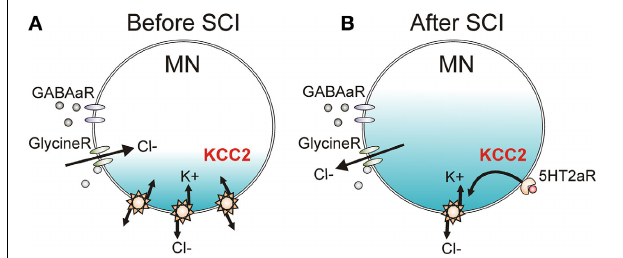
FIGURE 10 | KCC2 cotransporter and chloride equilibrium before and after SCI. (A) A potassium chloride cotransporter (KCC2) removes chloride (Cl − ) from the motoneuron (MN) in exchange for potassium (K + ) to maintain Cl − equilibrium potential below resting membrane potential, allowing Cl − influx and MN hyperpolarization during activation of GABA and Glycine receptors (R). (B) Downregulation of KCC2 expression in motoneurons after SCI increases intracellular Cl − concentration, depolarizing Cl − equilibrium potential to above rest. This produces efflux of Cl − and depolarization of MN during activation of GABA and Glycine receptors. Activation of 5-HT 2A receptors increases cell membrane expression of KCC2 after SCI to restore endogenous